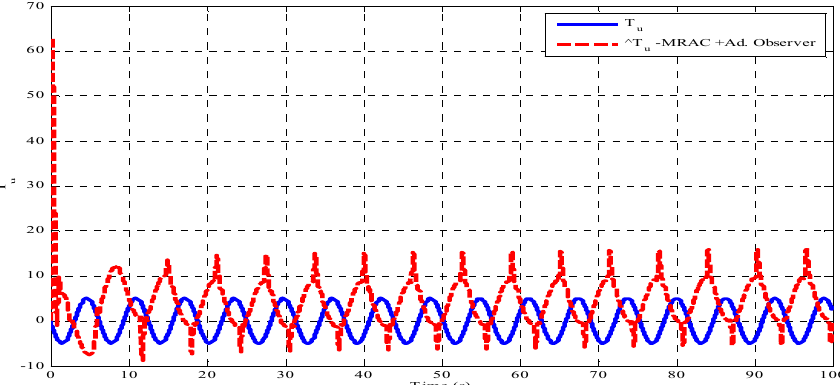
Figure 9. Disturbance estimations based on the three controllers.